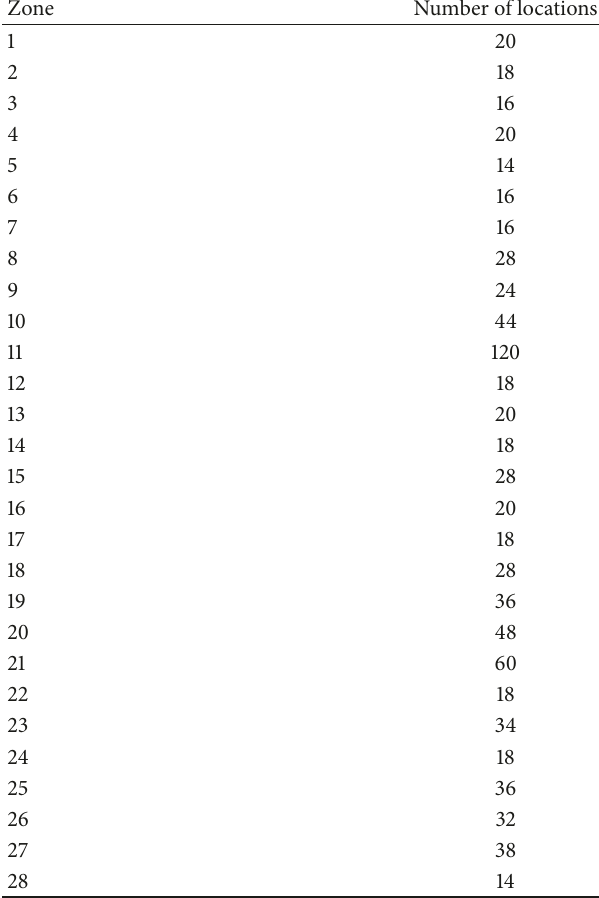
Table 6: Potential locations in which we allocate the FFBSS racks for each traffic zone.